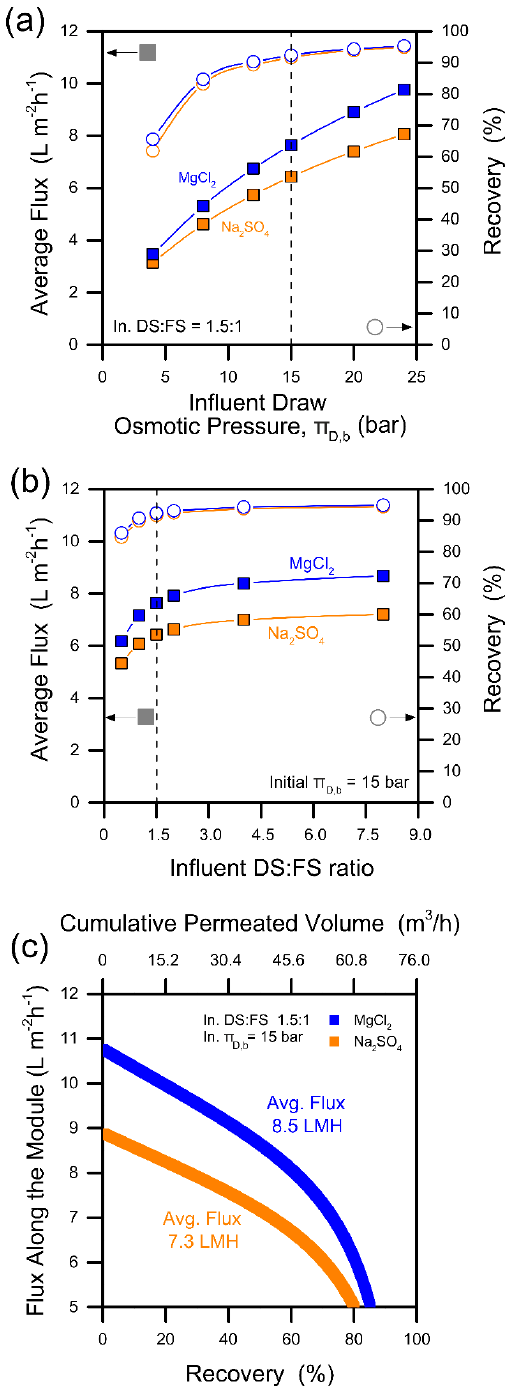
Figure 1. Choice of the forward osmosis (FO) operational parameters. The FO system was modeled in cocurrent mode. FO system recovery values (empty points) and related average modeled fluxes (full square points) as a function of ( a ) influent draw osmotic pressure and ( b ) influent ratio between the flow rates of the draw solution and the feed solution (DS:FS). Based on preliminary simulations presented in the Figure S1 of the Supporting Information, an influent DS osmotic pressure of 15 bar and an influent DS:FS ratio of 1.5:1 were considered, indicated by dashed lines. The curves in ( c ) are those modeled for the final FO system, considering the loss of driving force across the FO modules. Blue refers to MgCl 2 and red to Na 2 SO 4 . Solid lines in ( a , b ) are intended as guide for the eyes